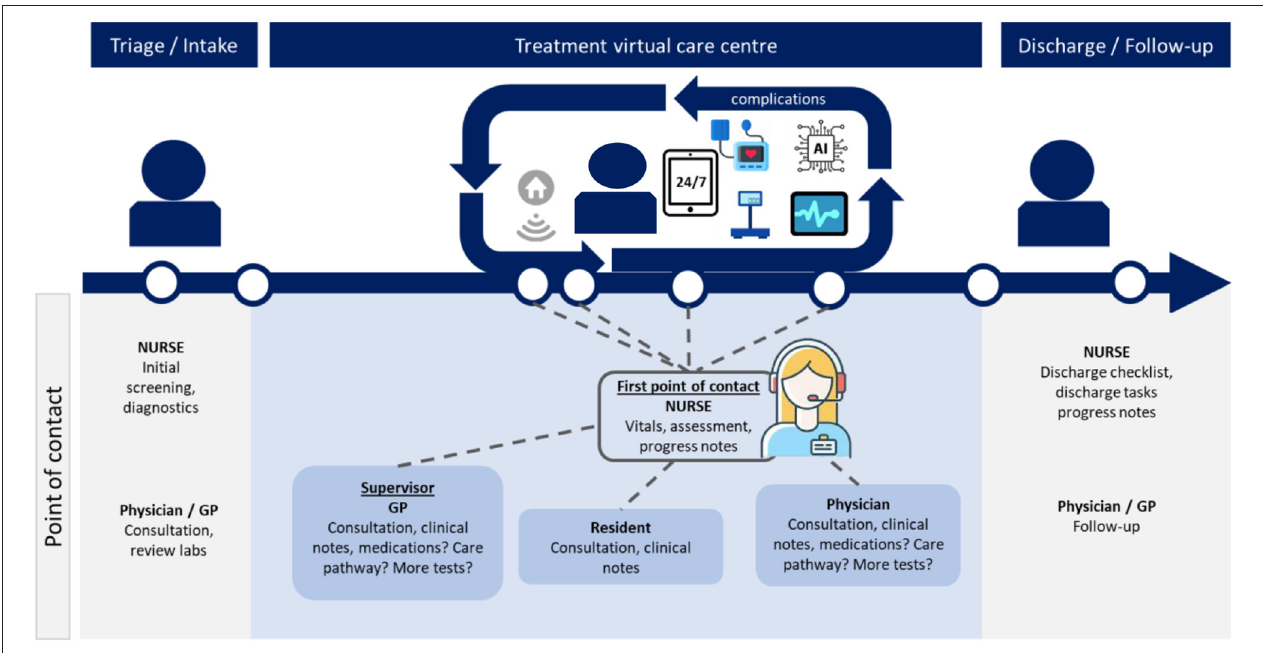
FIGURE 2 | Patient journey virtual care